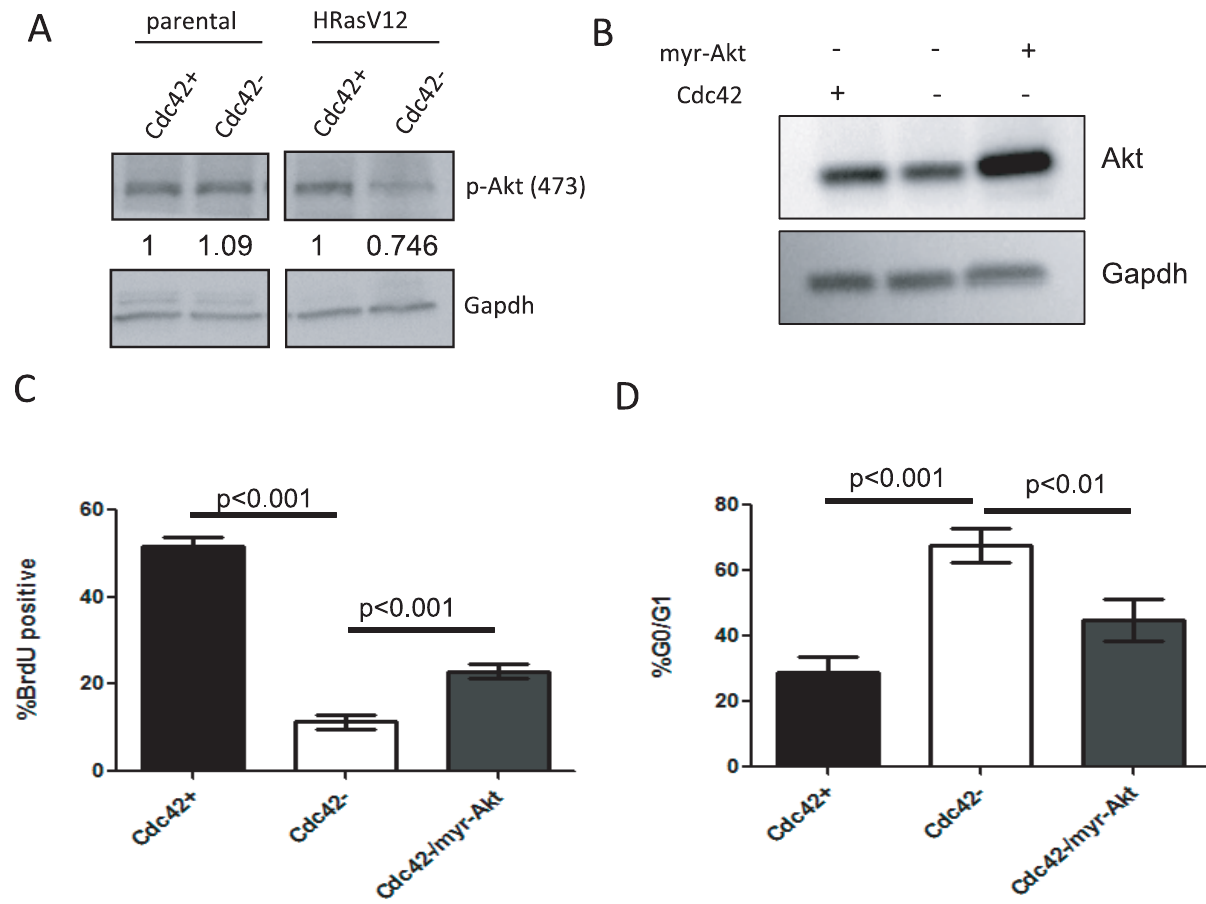
Figure 6. Growth defects observed in HRasV12-transformed cells following Cdc42 loss are partially rescued by activation of Akt signaling. ( a ) Cell lysates from non-transformed and HRasV12-transformed cells were immunoblotted for phospho-Akt. Gapdh serves as a loading control. ( b ) Cells were infected with Ad-GFP, Ad-GFP-Cre or Ad-GFP-Cre + Ad-myr-Akt. Cell lysates were obtained and blotted for Akt expression. ( c ) Exponentially growing cells were pulsed with BrdU for 1 hour prior to harvest. Cells were stained with anti-BrdU and PI and analyzed by flow cytometry. ( d ) PI staining was used to determine the percentage of cells with 2N DNA content. Graphs represent at least three independent experiments.